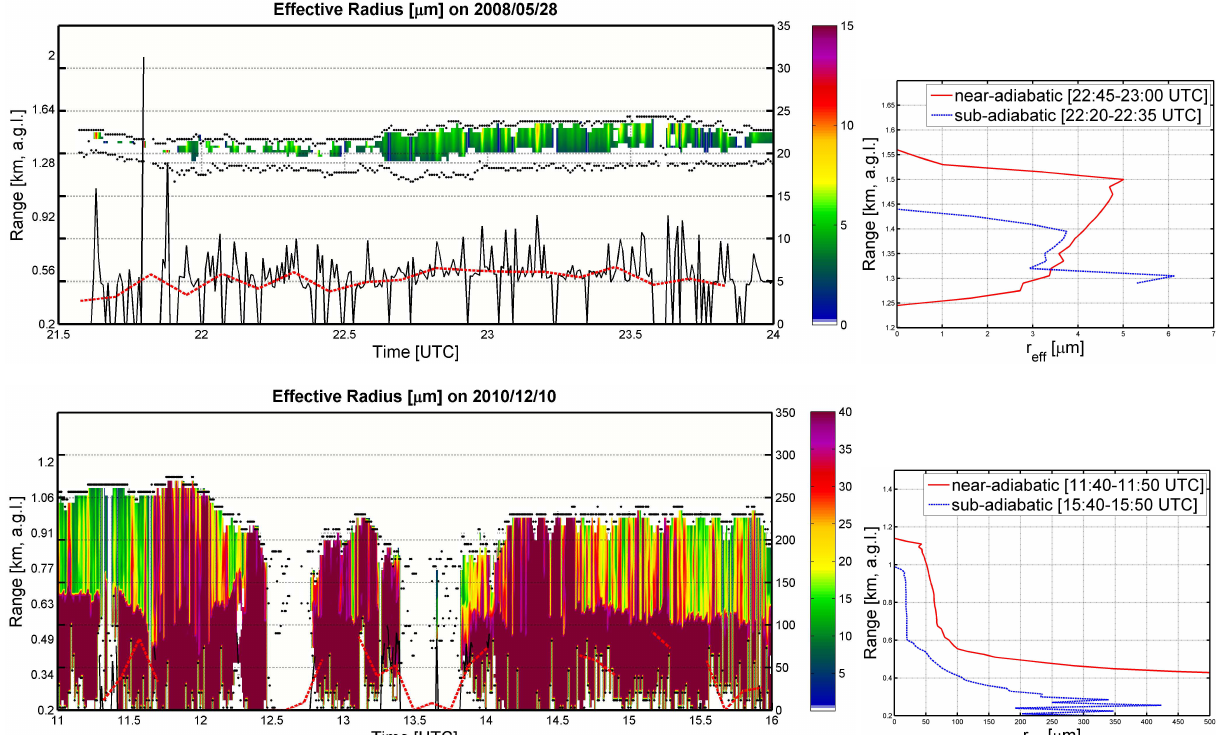
Fig. 7. Continental (top) and marine (bottom) case: time-height cross section of the effective radius r eff [µm]. Layer-averaged black and red curves at each panel’s bottom (right y-scale in [µm]) have 0.5-min and 7.5-min temporal resolution, respectively. Profiles in highlighted frames show near-adiabatic (solid red) and sub-adiabatic (dashed blue) r eff profiles corresponding to, respectively, maxima and minima of the departure function f (z)